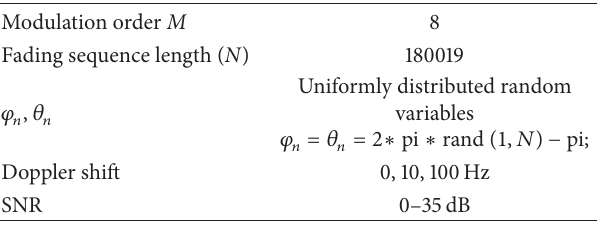
Table 2: Fading channel parameters.